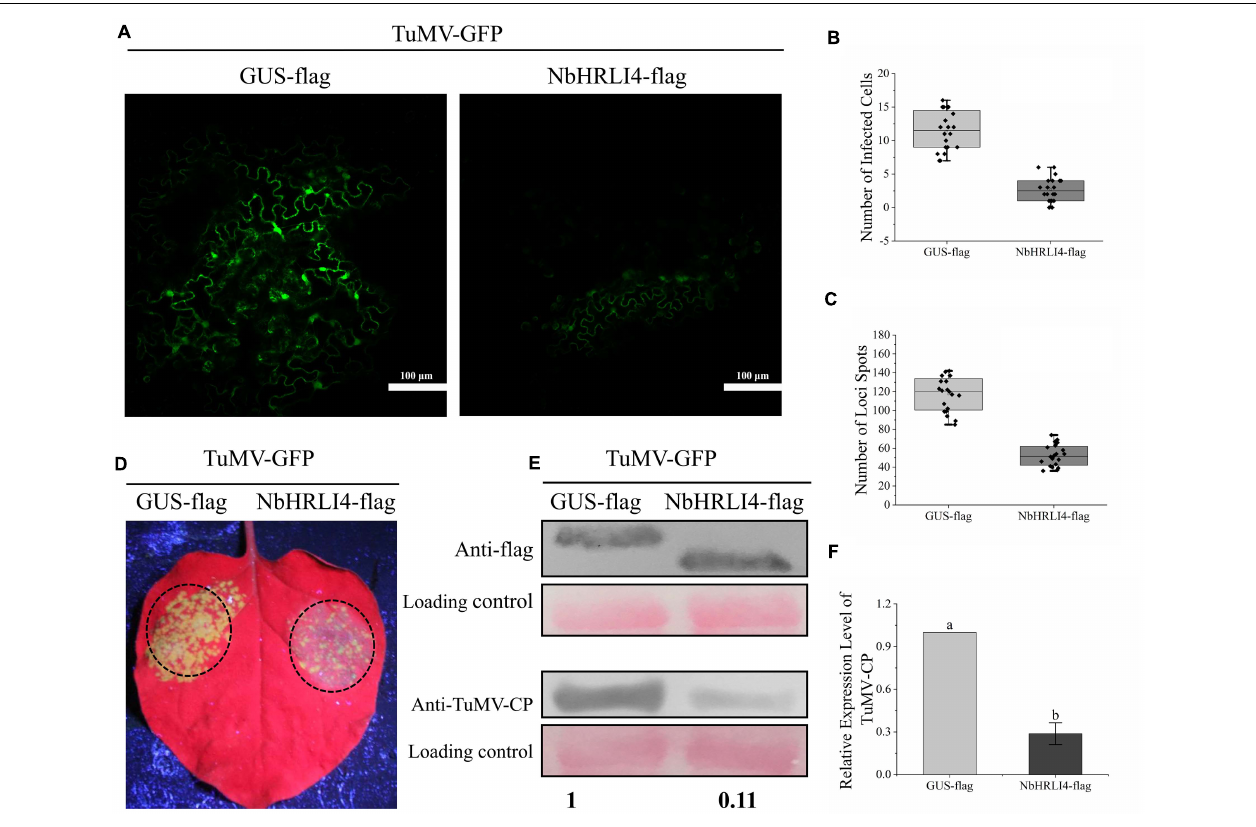
FIGURE 4 | Overexpression of NbHRLI4-reduced TuMV accumulation. (A) Green fluorescence observed by laser confocal microscopy in infected cells of leaves overexpressing NbHRLI4-flag or GUS-flag at 72 hpi. Bars = 100 µ m. (B) Numbers of infected cells in leaves overexpressing NbHRLI4-flag or GUS-flag (at least 20 photos per replicate) determined using the laser confocal microscope at 72 hpi. (C) Number of necrotic spots on inoculated leaves overexpressing NbHRLI4-flag or GUS-flag (at least 20 plants per replicate) at 4 dpi. (D) Leaves overexpressing NbHRLI4-flag or GUS-flag and inoculated with TuMV-GFP observed under UV light at 4 dpi. (E) Western blotting detection of NbHRLI4-flag, GUS-flag, and TuMV-CP at 4 dpi. (F) RT-qPCR detection of TuMV mRNA in inoculated leaves from WT plants overexpressing NbHRLI4-flag or GUS-flag. The mean expression values were analyzed using t -test. Different letters on histograms indicate significant differences ( P <